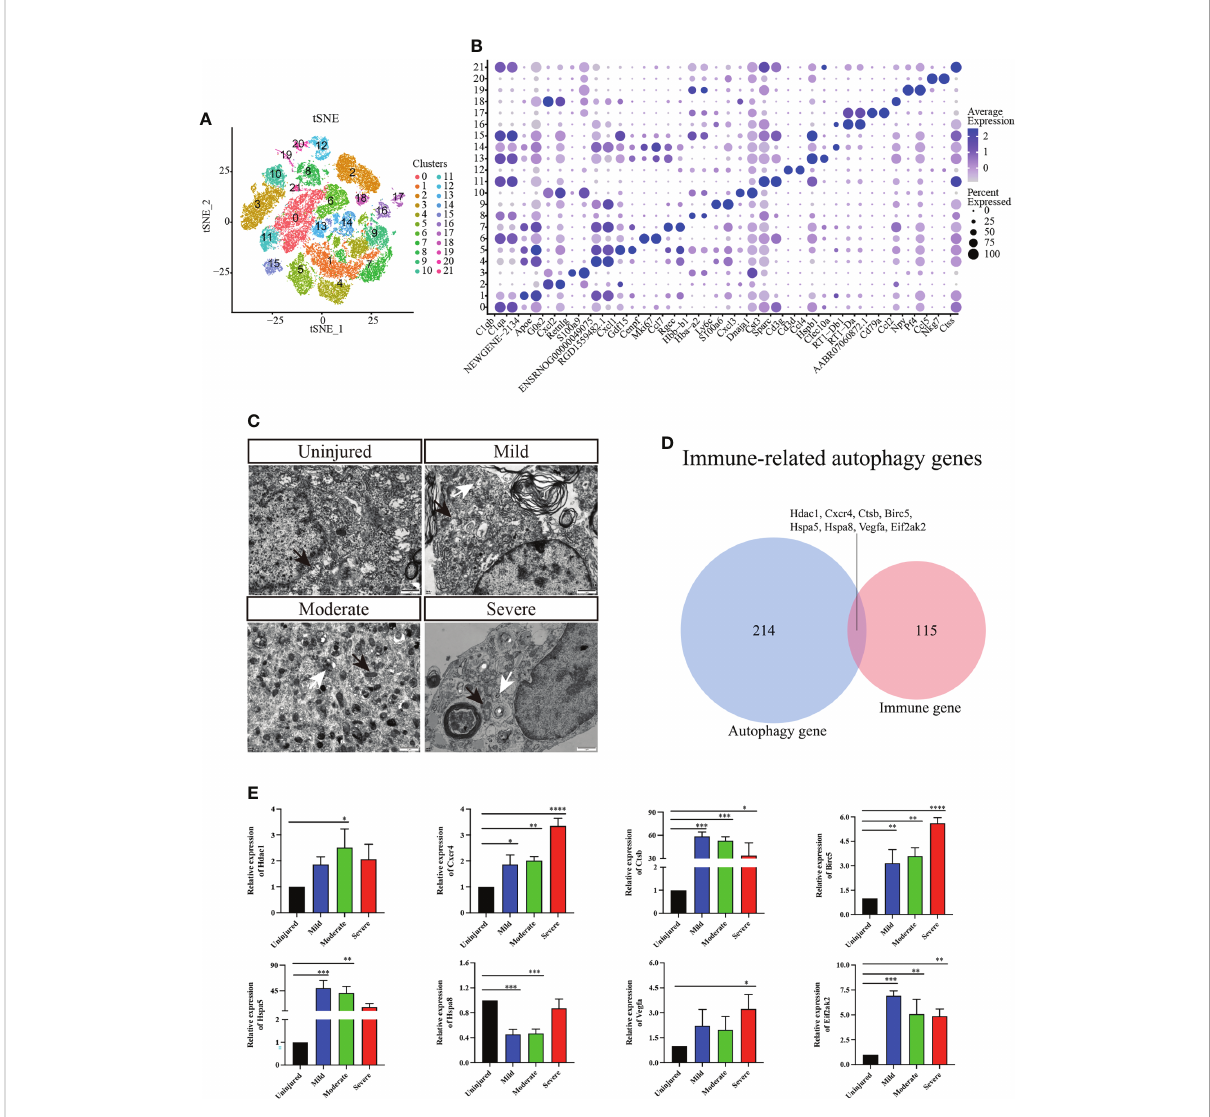
FIGURE 2 Immunocyte subgroup analysis and pseudosequential analysis. (A) t-distributed stochastic neighbor embedding (t-SNE) distribution of different cell clusters. (B) Bubble diagram showing the differentially expressed genes among different clusters and display the two most highly expressed genes of each cluster by bubble diagram. (C) Electron transmission microscopy of spinal cord tissue. Magni fi cation, 5000X. Scale bars, 1 m m. White arrows indicate autophagosomes and black arrows indicate mitochondria. (D) Venn diagram of immune-related autophagic factors. (E) Effect of changes in mRNA expression of IRAFs Hdac1, Cxcr4, Ctsb, Birc5, Hspa5, Hspa8, Vegfa, and Eif2ak2 (real-time qPCR) in the injured rat spinal cords. The mRNA expression levels were calculated using the 2 - DD Ct analysis method. *P < 0.05, **P < 0.01, ***P < 0.001, vs. the control group. Data are expressed as the mean ± SD (n = 3; one-way analysis of variance and Tukey ’ s post-hoc test). The experiment was repeated in triplicate.